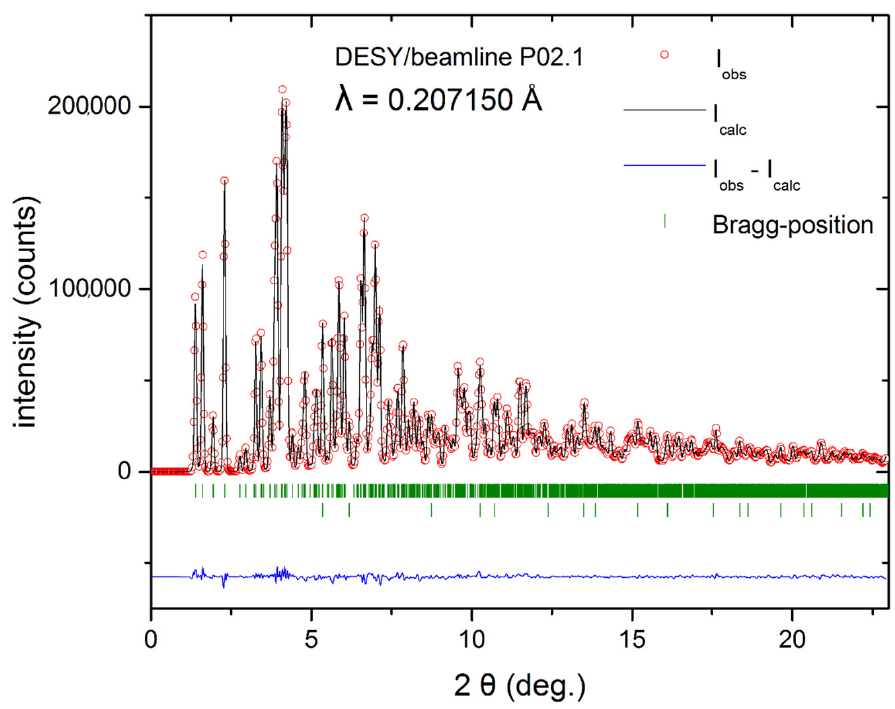
Figure 2. Rietveld-refinement of the powder diffraction pattern of Ca 1 − x Ir 4 S 6 (S 2 ) obtained with synchrotron radiation.